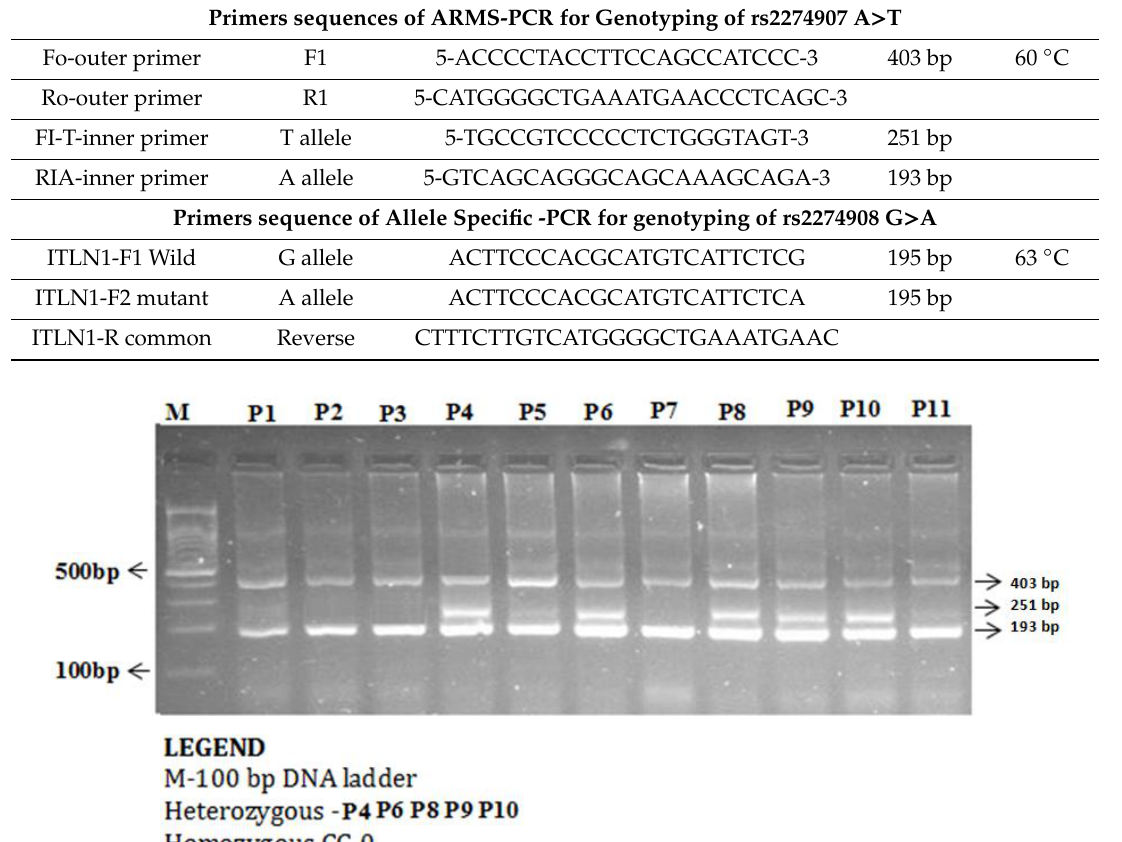
Table 1. Primers sequences of ARMS-PCR and Allele Specific-PCR.